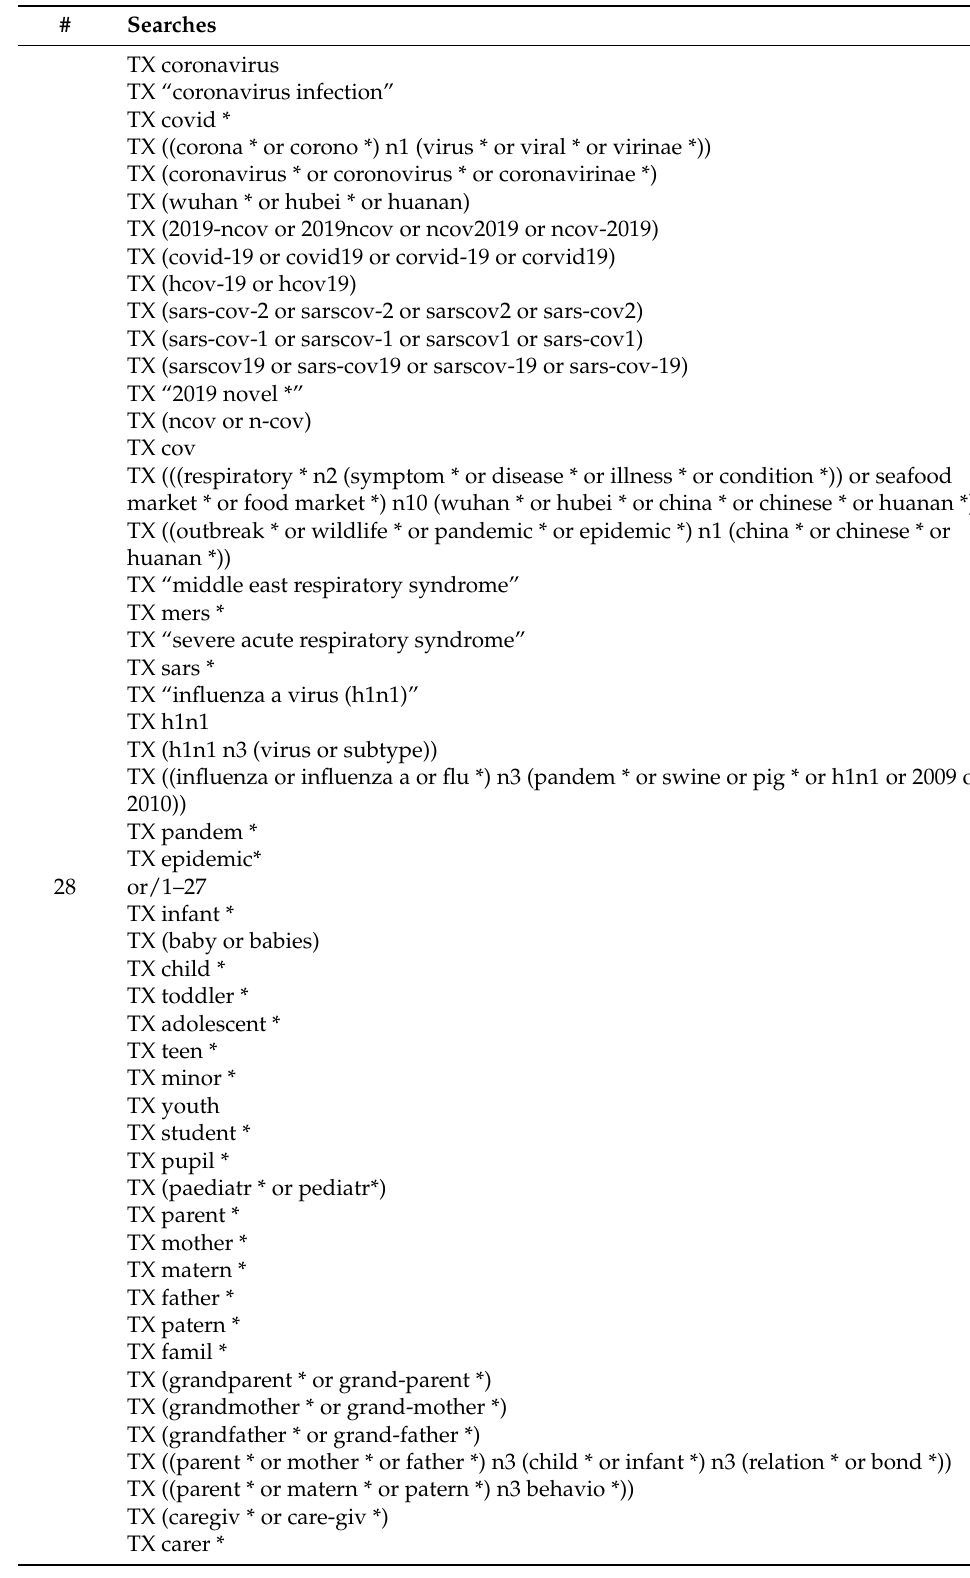
Table A3. Search